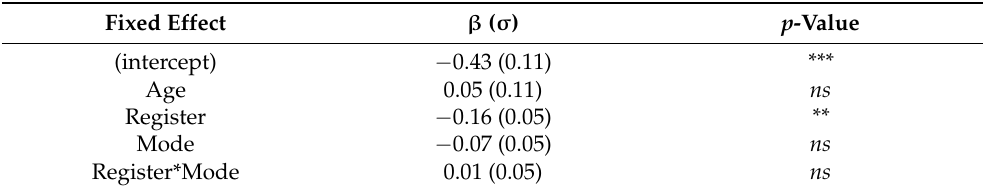
Table A3. USA. Regression table for binomial GLMM with the dependent variable Connector and the independent variables Age, and the interaction of Register and Mode. Outputs for by-Country binomial GLMM.